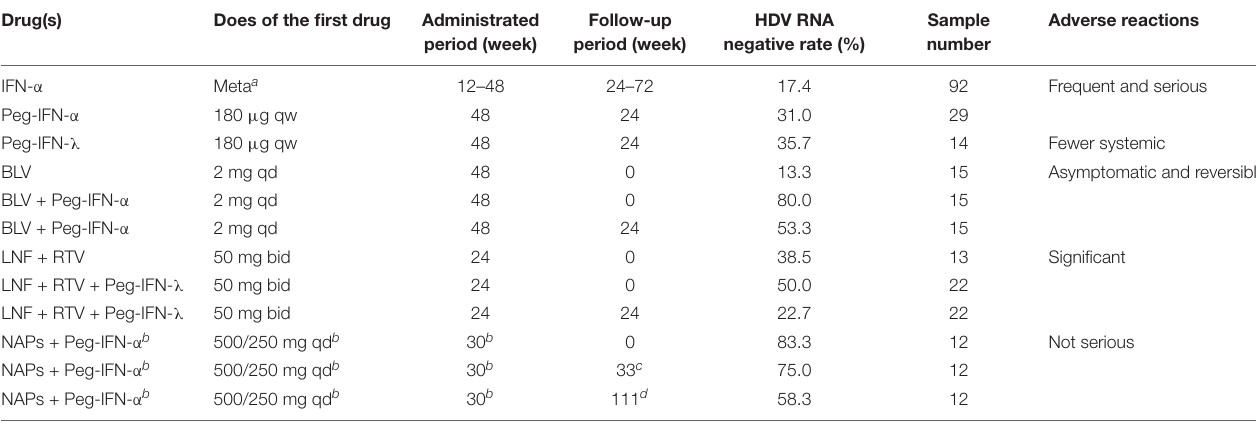
TABLE 2 | Comparison of the effects of different drugs on